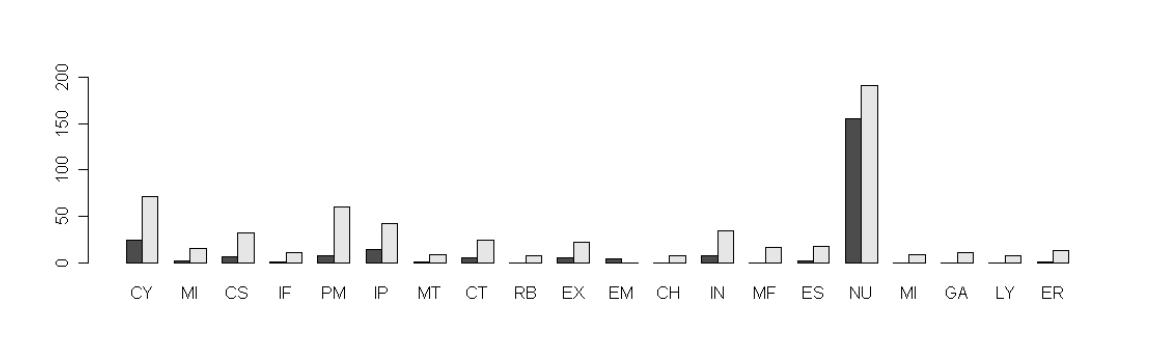
Figure 2: Sub-cellular localization of the detected modules. The number of modules is shown for which the majority (black bars) or a fraction of the included proteins (gray bars) was assigned to the corresponding cellular compartment. The distribution is based on the analysis of 316 modules which have a clique size k > 3. The following abbreviations are used: CY-cytoplasm, MI-mitochondrion, CS-cytoskeleton, IF-intermediate filament, PM-plasma membrane, IP- integral to plasma membrane, MT-microtubule, CT-cytosol, RB-ribosome, EX-extracellular region, EM-extracellular matrix, CH-chromosome, IN-intracellular, MF-membrane fraction, ES-extracellular space, NU-nucleus, MI-microsome, GA-Golgi apparatus, LY-lysosome and ER- endoplasmic